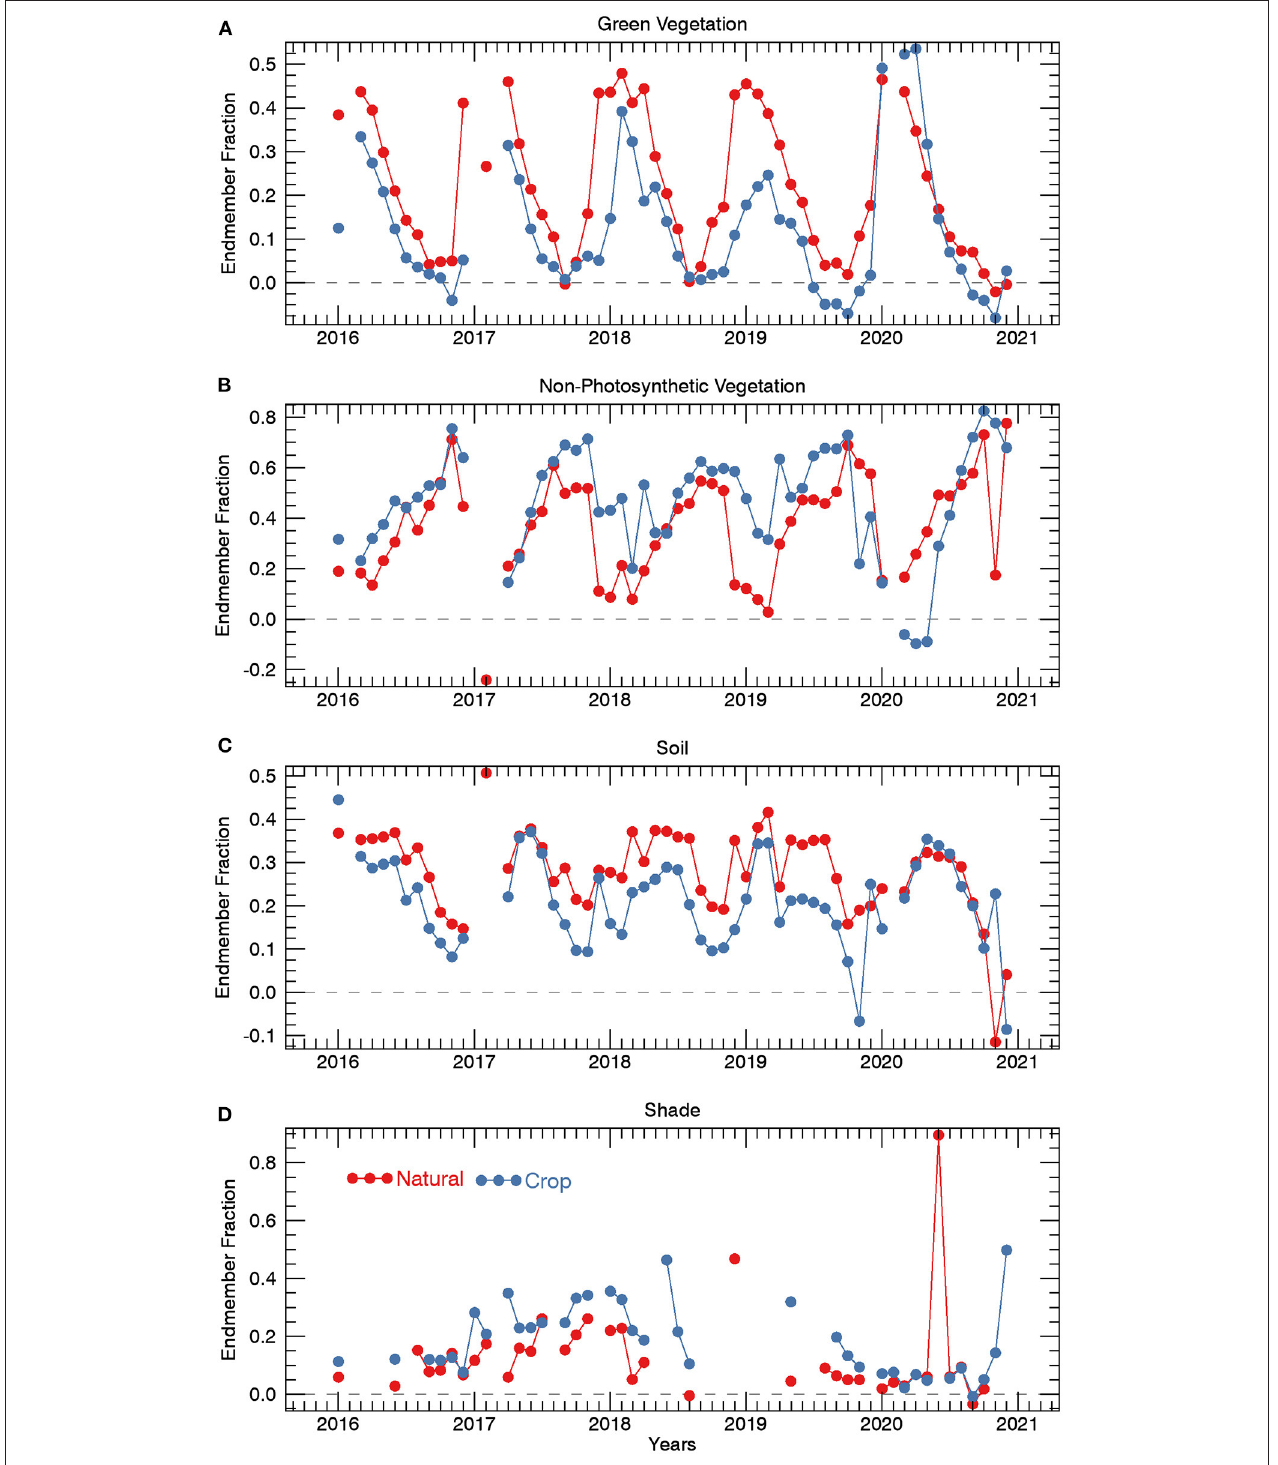
FIGURE 4 | Sample green vegetation (GV) (A) , non-photosynthetic vegetation (NPV) (B) , soil (C) , and shade (D) endmember (EM) trajectories for a crop area and a natural area, showing monthly median values.